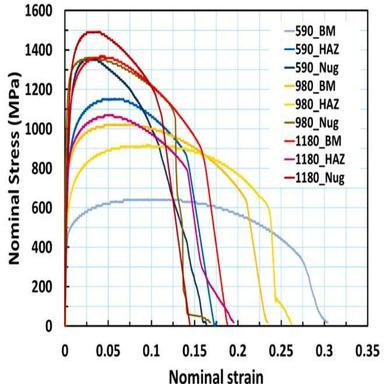
Nominal strain–stress gauged from miniature tensile experiments of different zones for spot-welded JSC590, JSC980, and JSC1180.